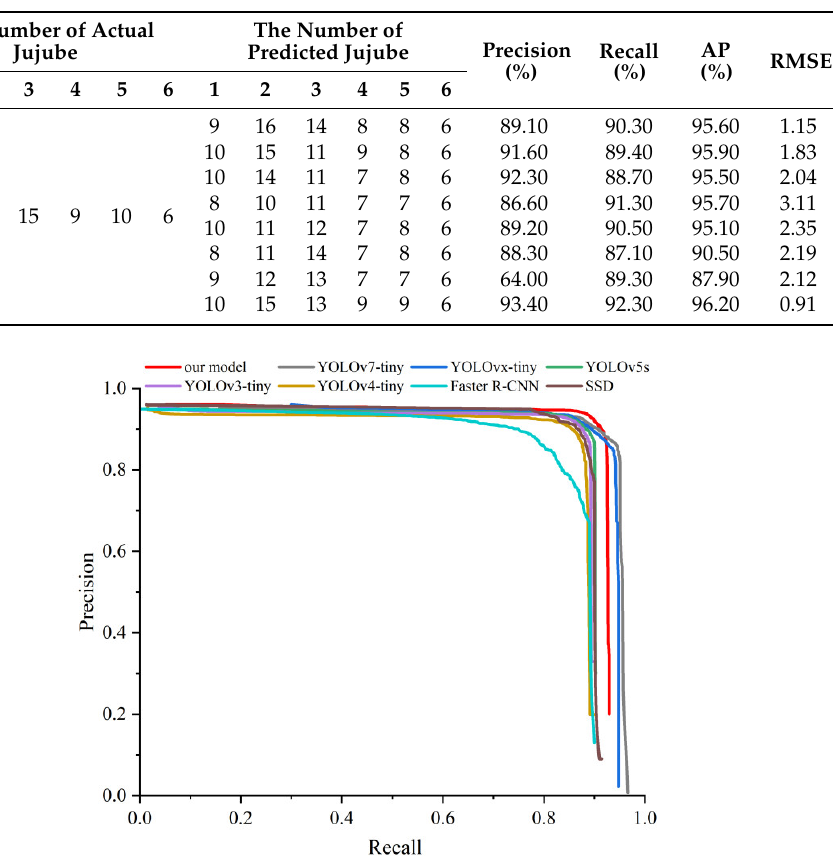
Table 5. Detection results of red jujubes with different target detection algorithms.